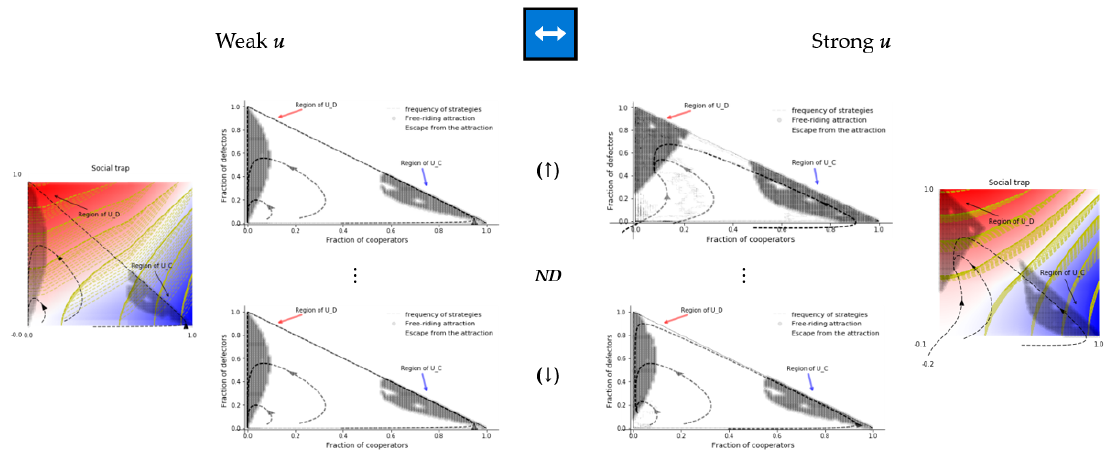
Figure 8. Cultural evolutionary dynamics using replicator–mutator, including network characteristics. In the left plot, r = 3, c = 1, g = 0.5, and µ = 1 × 10 − 10 . In the center-left plot ( ND = network density; see Table 8 for more detail about the added parameters), r = 3, c = 1, g = 0.5, µ = 1 × 10 − 10 , upper ND = 0.9, and bottom ND = 0.1. In the center-right plot, r = 3, c = 1, g = 0.5, µ = 1 × 10 − 10 , upper ND = 0.9, and bottom ND = 0.1. In the right plot, r = 3, c = 1, g = 0.5, and µ = 1 × 10 − 3 . The dotted lines show the homoclinic orbit for three assessment strategies (with different initial points). U_D denotes an unstable region of defection and cooperation